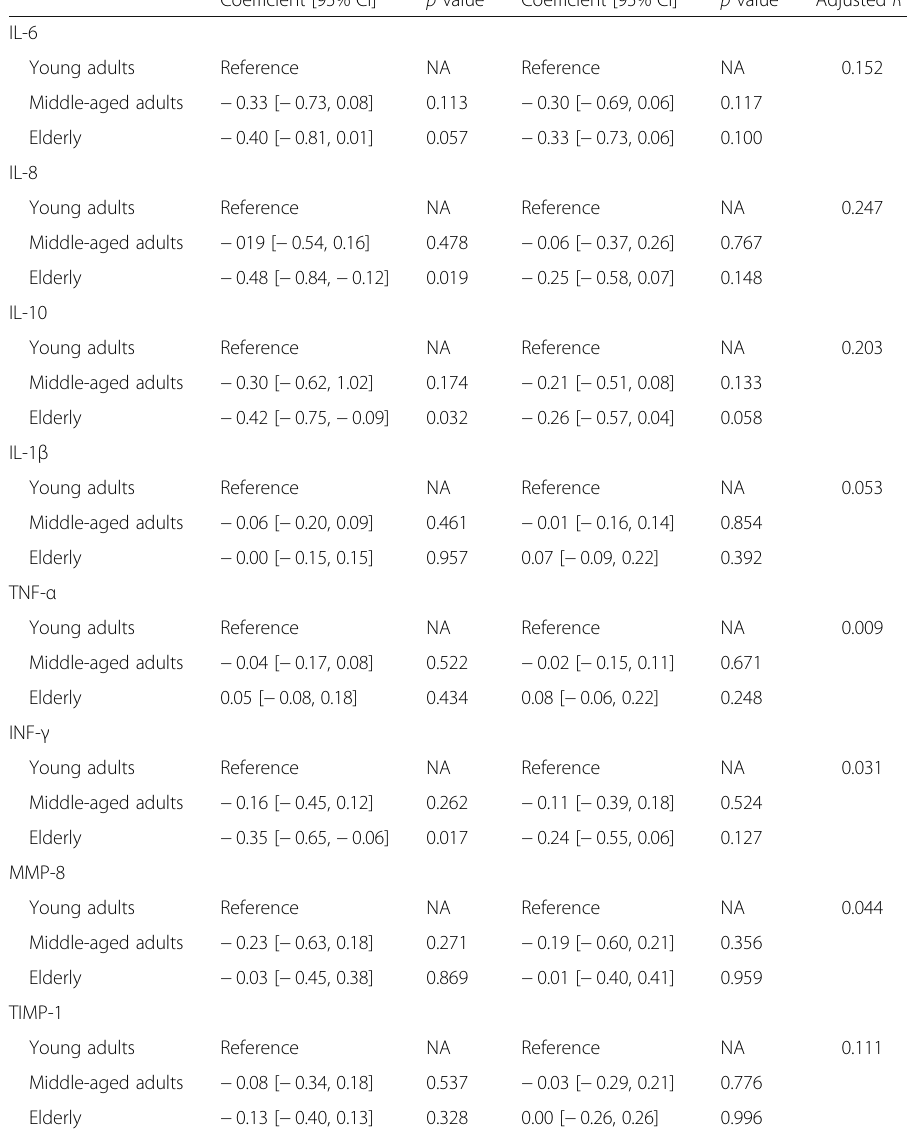
Table 3 Association between age and inflammatory marker levels in ARDS patients (mediation step